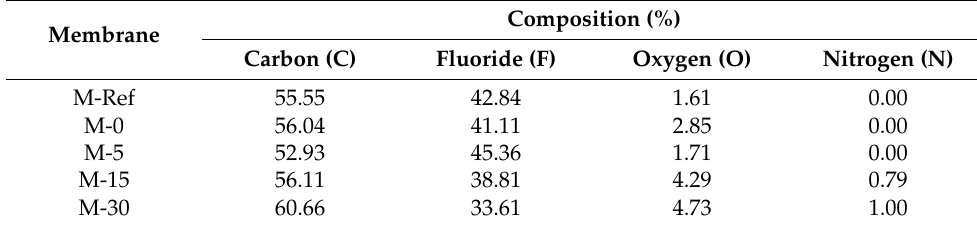
Table 2. Elemental composition of the resulting membranes by energy dispersive X-ray (EDX) analysis. Composition (%) Membrane Carbon (C) Fluoride